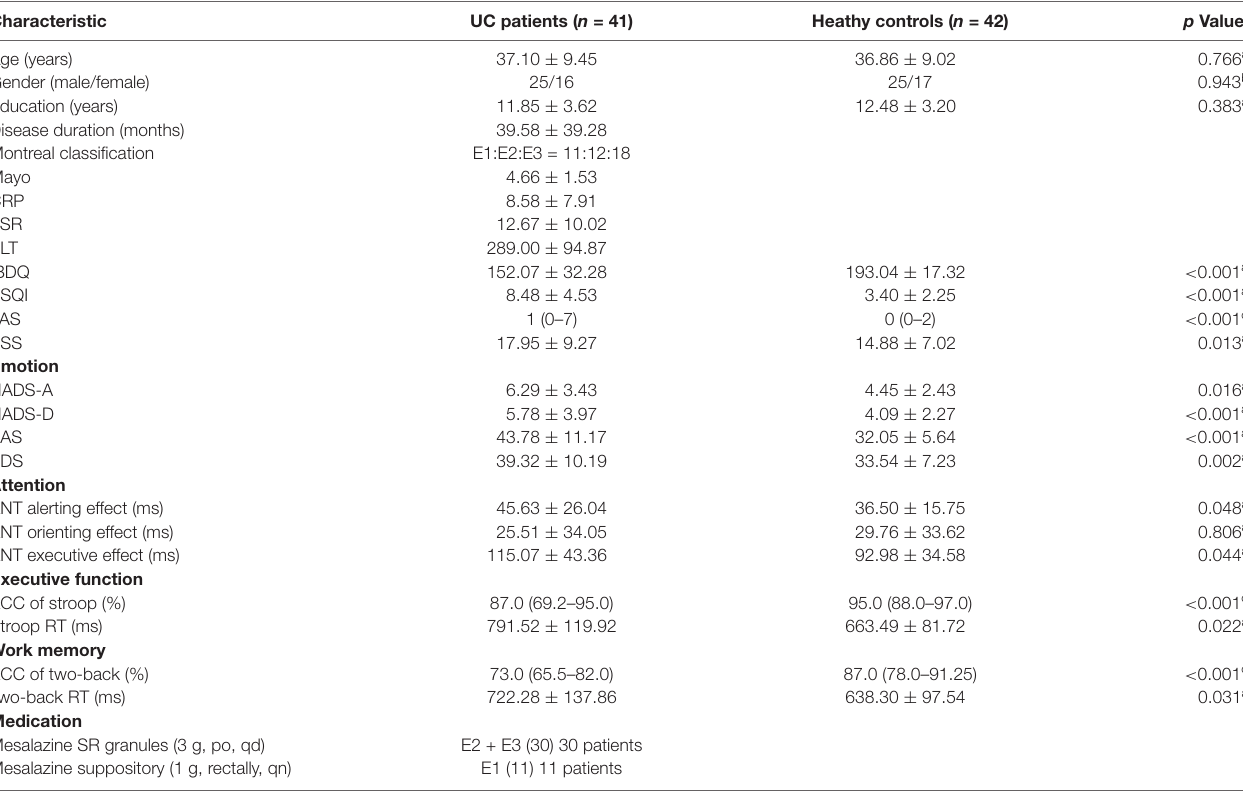
TABLE 1 | Demographics, clinical data, mood and cognitive performance among Ulcerative colitis (UC) and healthy control (HC).